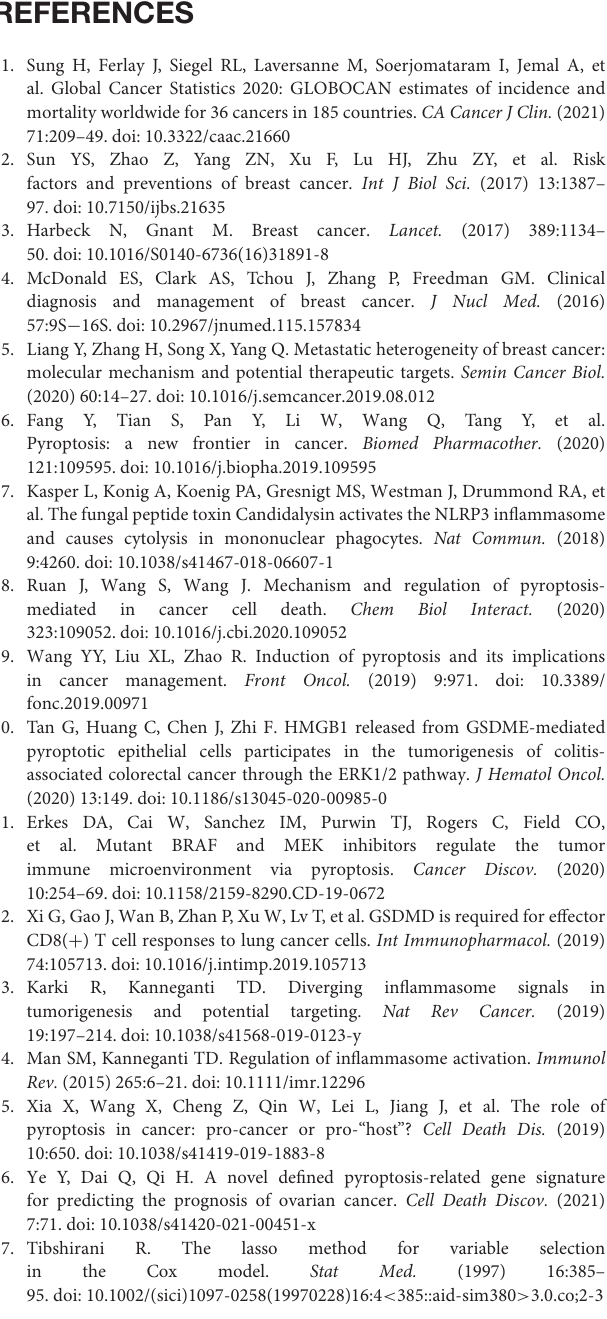
Supplementary Figure 1 | GSEA enrichment analysis for IL-18, NLRC4, TIRAP, TNF in BRCA. (A) KEGG and (B) GO pathway analysis for IL-18 in BRCA. (C) KEGG and (D) GO pathway analysis for NLRC4 in BRCA. (E) KEGG pathway